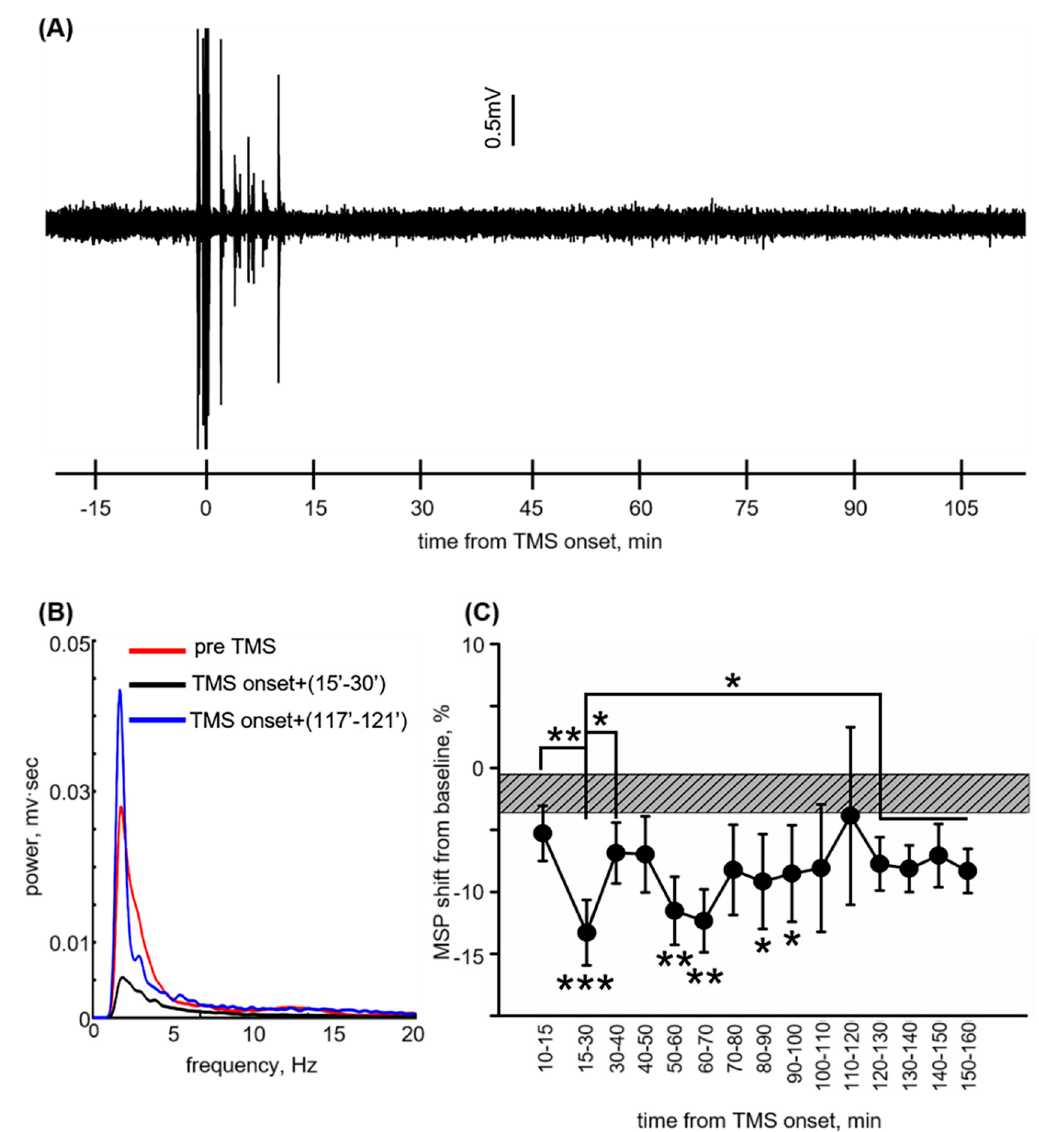
Figure 2. Electrocorticography (ECoG) recording indicates reversible post-stimulation depression. ( A ) Electrocorticography of an anesthetized rat during rTMS; 0 min = rTMS onset. ( B ) Mean signal spectrum at pre rTMS (baseline, red),15–30 min (black), and 117–121 min (blue) post-TMS onset. ( C ) Mean ± SEM spectral power (MSP) shift from baseline at different time points after TMS onset. Grey box indicates mean ± SEM baseline spectral power shift. * p < 0.05, ** p < 0.01, *** p < 0.001.